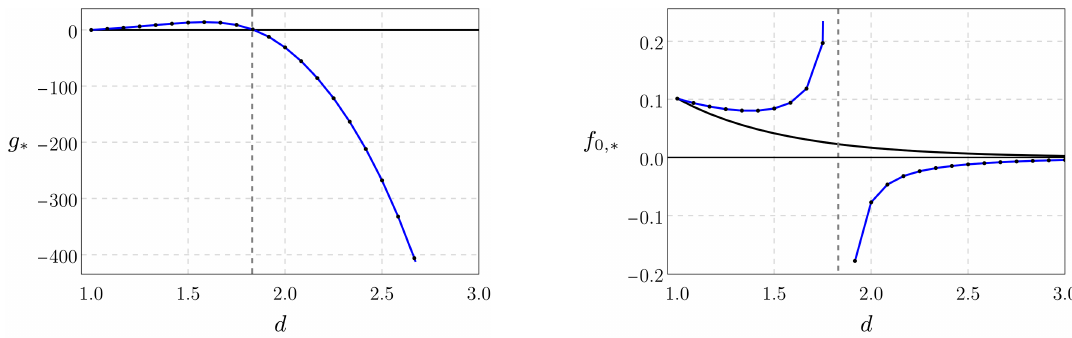
Figure 6 . Variation of g ∗ and f 0 , ∗ with the spatial dimension d (blue lines), for N = 2 . The NGFP emerging from the GFP in d = 1 + (cid:15) dimensions disappears at a critical dimension d dashed line) and is replaced by another fixed point at g Both fixed points are characterized by f (black line) is also shown for